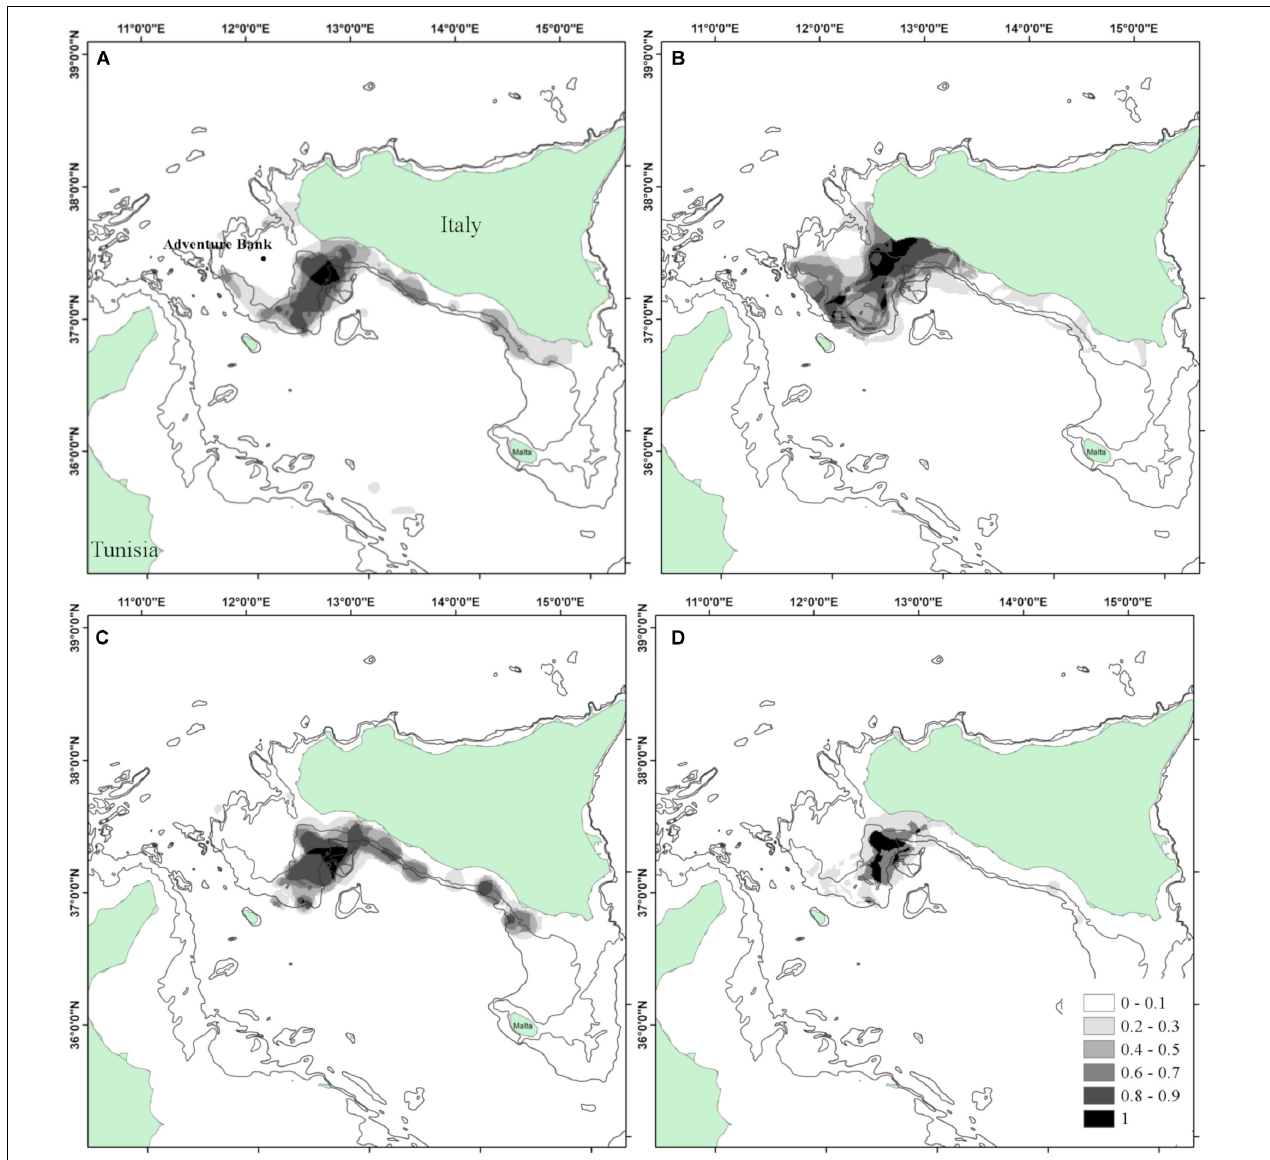
FIGURE 4 | Area 2 – Strait of Sicily. (A) Persistence index of M. merluccius ; (B) persistence index of Trachurus trachurus ; (C) persistence index of Parapenaeus longirostris ; (D) Interspecific persistence index (IPI). Depth contours shown are 100 and 200 m.